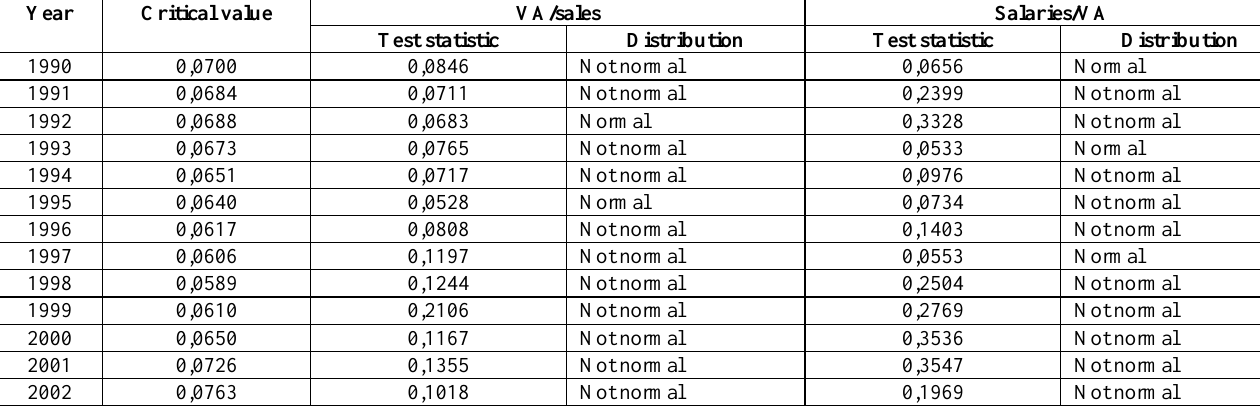
Table 2: Lilliefors test for normality applied to VA-ratios 1990 to 2002 – full sample